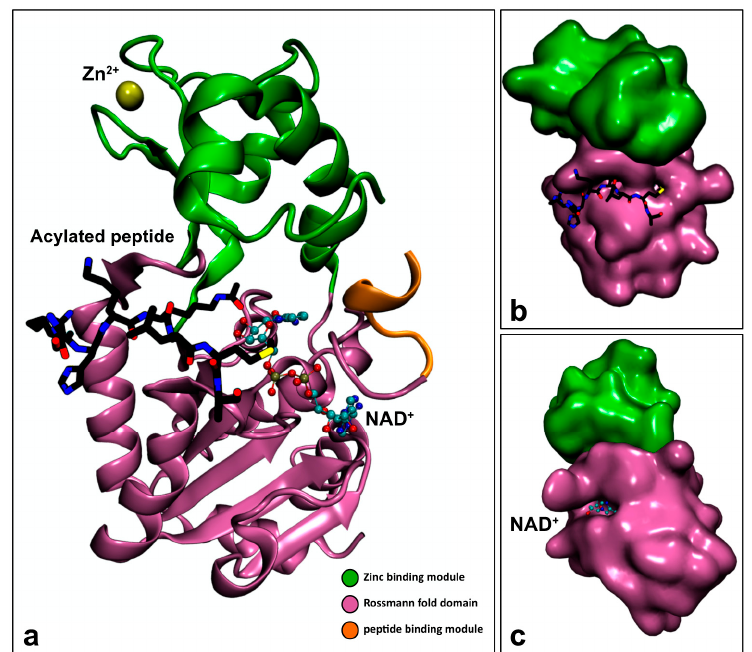
Figure 3. ( a ) VMD representation of the crystallographic structure of a ternary complex from a